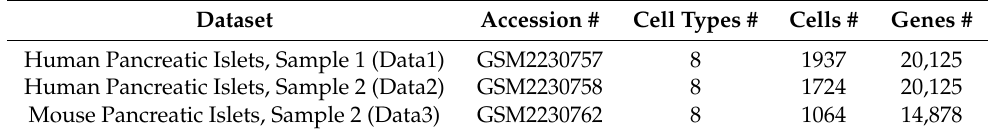
Table 1. Details of the datasets analyzed in this study.